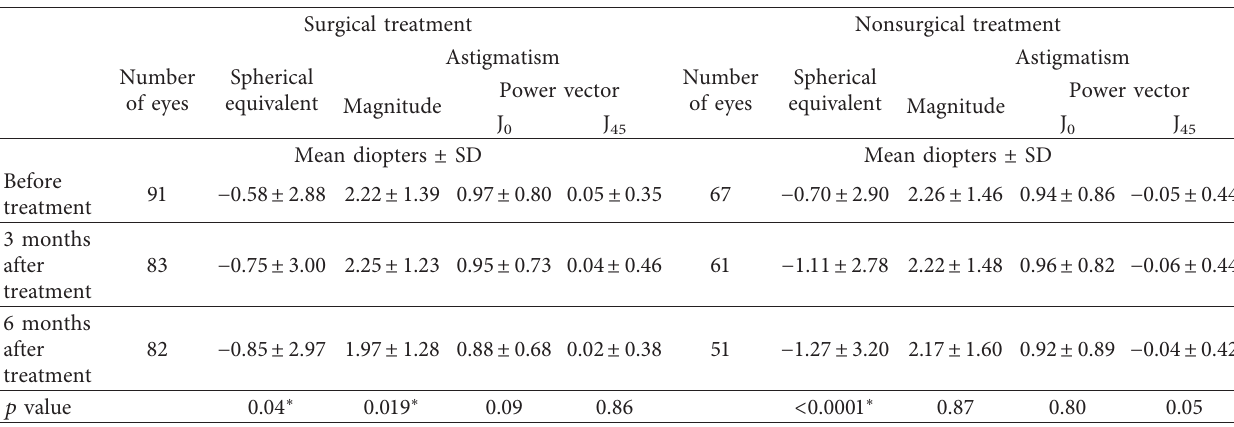
Table 3: Refractive status of the two study groups at baseline and 3 and 6 months after